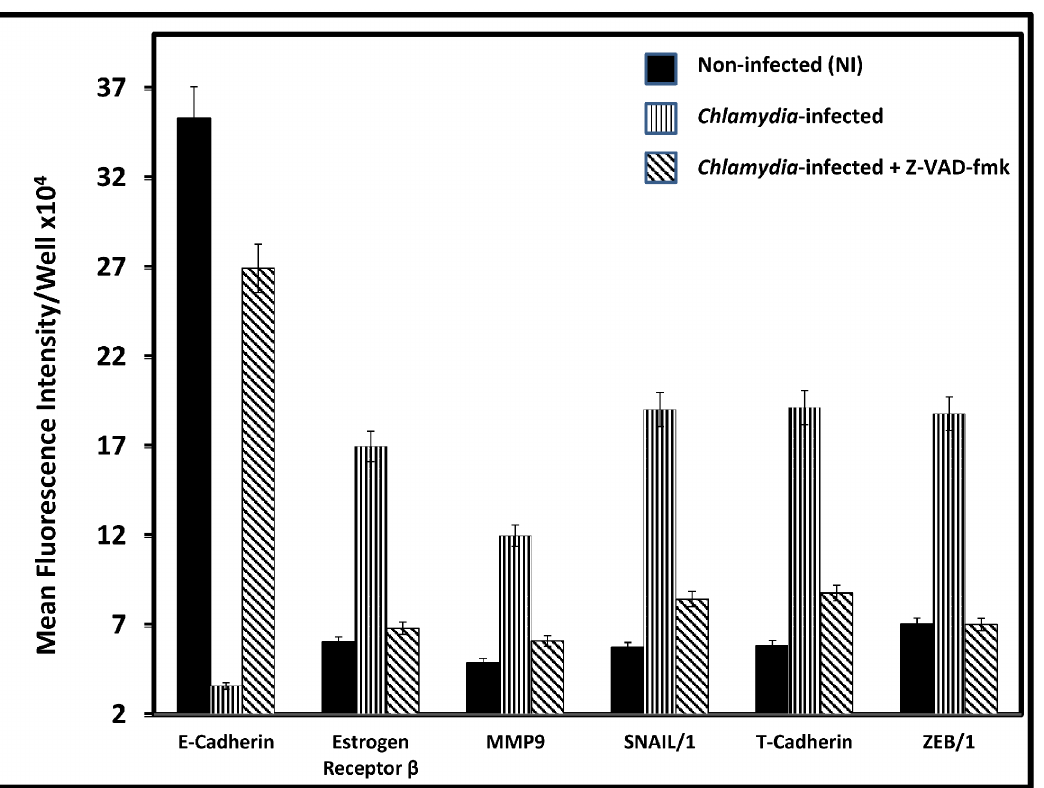
Fig 9. Caspase inhibition prevented chlamydial-induced EMT. Monolayers of murine oviduct epithelial cells were infected with C . trachomatis L and after 72h immunofluorescence staining of the cells for epithelial and EMT markers was performed on infected and non-infected monolayers by standard procedures. Z-VAD-FMK and the control Z-FA-FMK were used in culture at 50 micromole. Quantification of fluorescence was performed by scanning fluorescent-stained cells at 20X objective on a Nikon fluorescent microscope using the NIS-Elements Imaging Software version 3.20 (Nikon Instruments Inc, Melville, NY USA). Images were acquired for experimental and control cultures with the same microscope settings, exposure time and background. The mean fluorescence intensity and standard deviations of 6 out of 10 scanned fields per slide were calculated automatically by the software. Plotted data were derived from 5 independent